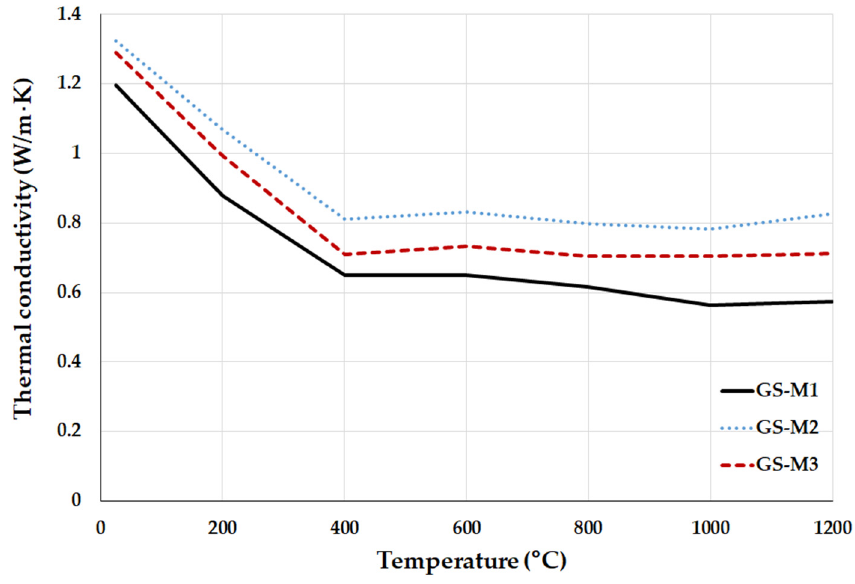
Figure 8. Thermal conductivity of geopolymer composites with different types of aluminosilicates at laboratory temperature and after exposure up to 1200 °C.